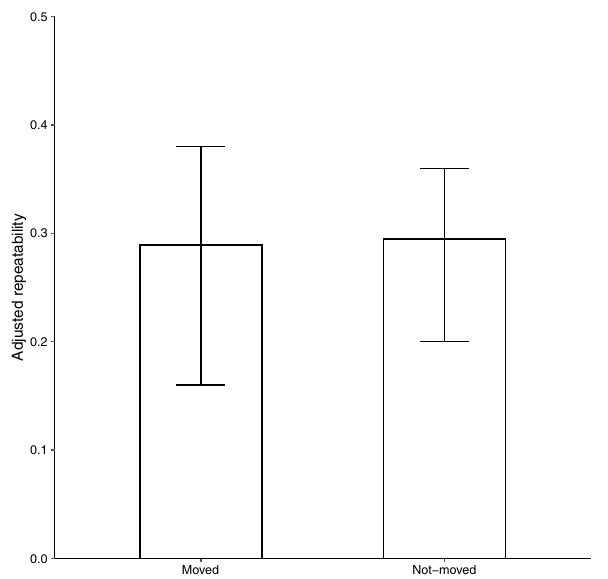
Figure 2. The long term repeatability of emergence time for females that did not move between nest boxes and females that moved (adjusted for year, age, date, date 2 and temperature at sunrise). 95% confidence intervals are